Question: Is the quantity shown trending increasing or decreasing?
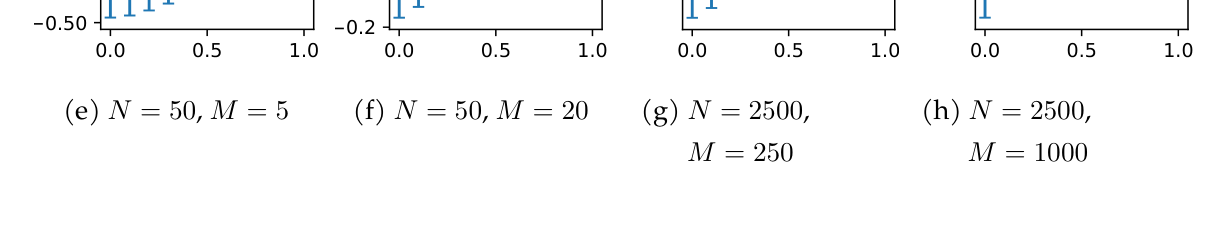
Answer: increasing